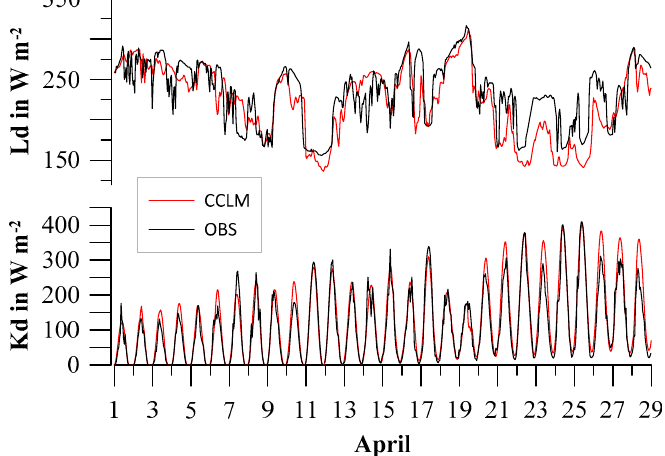
Figure 4. As in Figure 3, but for downward shortwave (Kd) and downward longwave radiation